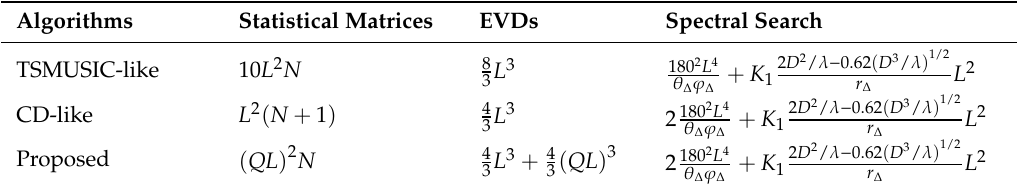
Table 1. Computational complexity